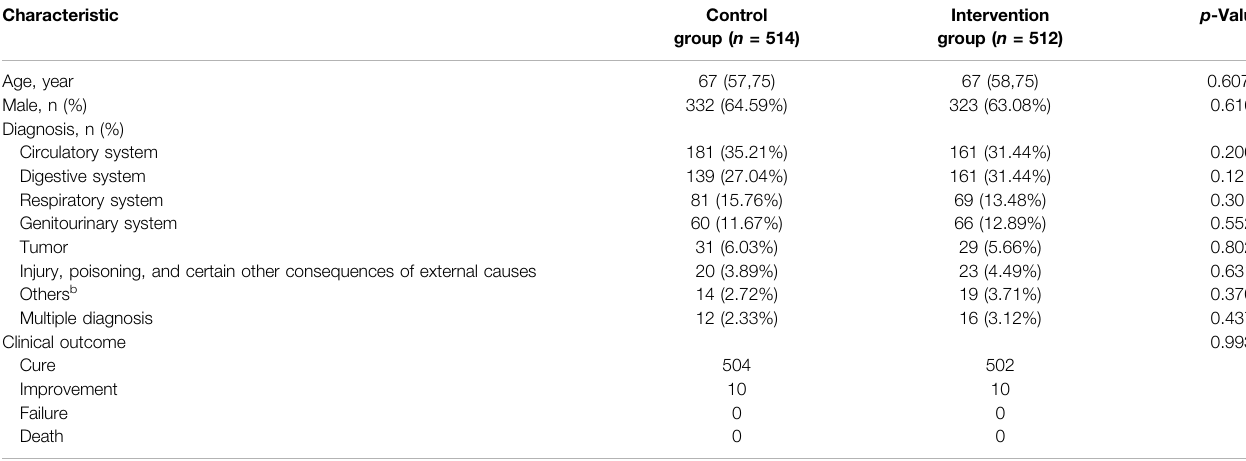
TABLE 1 | Comparison of the characteristics of patients in the control group and intervention group.